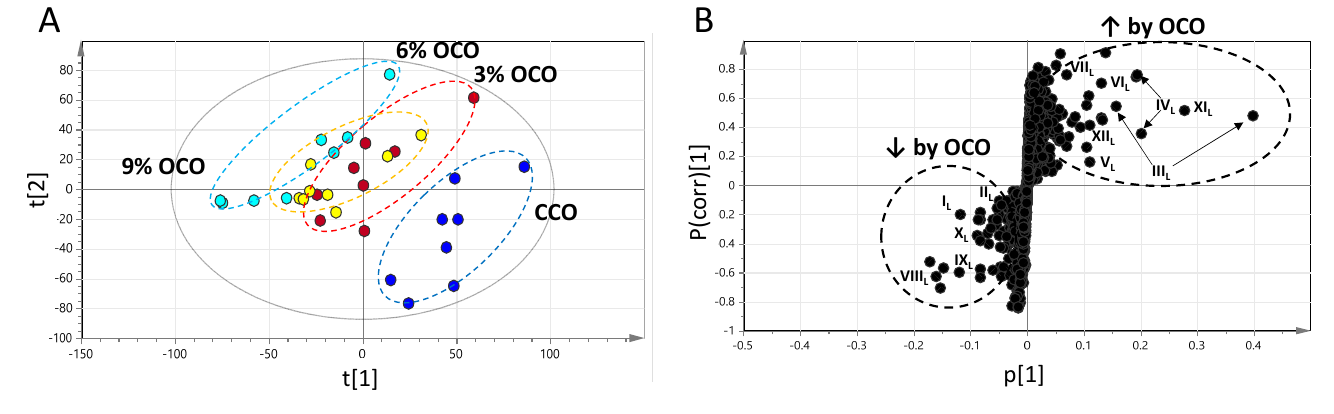
Figure 3. Influences of feeding oxidized corn oil (OCO) on hepatic metabolome. Data from LC-MS analysis of liver extractions were processed by PLS-DA modeling. ( A ) Scores plot of the PLS-DA model on liver samples. ( B ) S-plot of the OPLS-DA model on liver samples. The OCO-responsive metabolites are labeled (I L –XII L ). Table 3. Identification of hepatic metabolites changed by oxidized corn oil (OCO) feeding. The